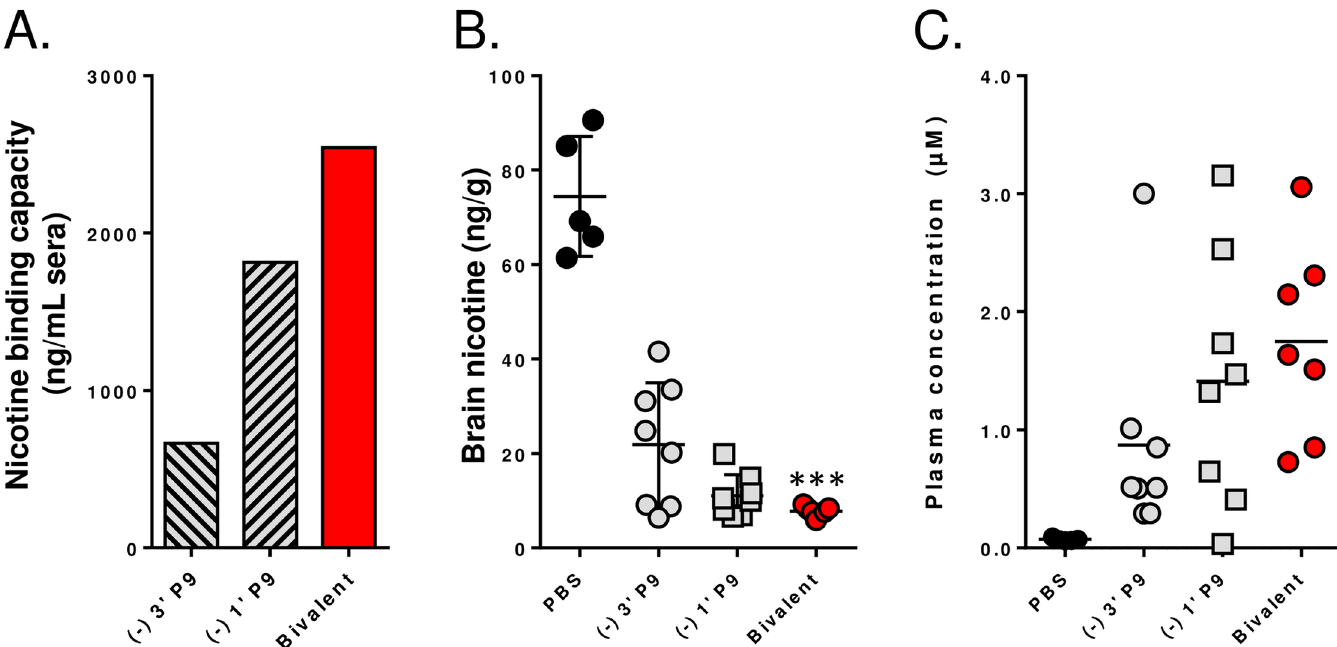
Fig 8. Functional antibody responses are improved with a bivalent vaccine. Plasma was collectedon day 56 and pooledfrom mice immunizedon days 0, 21 and 42 to determine nicotine bindingcapacity by equilibriumdialysis(A). Fourteen days later, mice were injectedwith an amount of nicotinetartrate equivalentto 12 cigarettes (0.2 mg/kg). Mice were sacrificedafter 5 minutes and nicotine levels were measuredon brain (B) and plasma (C) by LC-MS/MS.